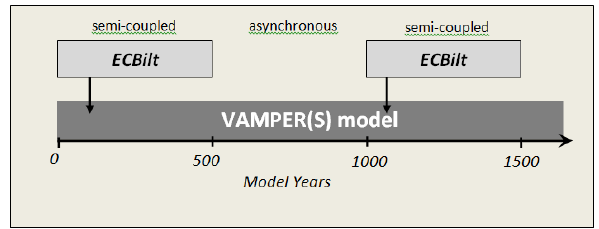
Figure 6. An illustration of asynchronous coupling between VAM- PER(S) and ECBilt. The components are run semi-coupled for 100 years while VAMPER(S) is run the entire time. This allows VAMPER(S) to equilibrate with the climate state of i LOVECLIM using less computer resources time than a synchronous version.